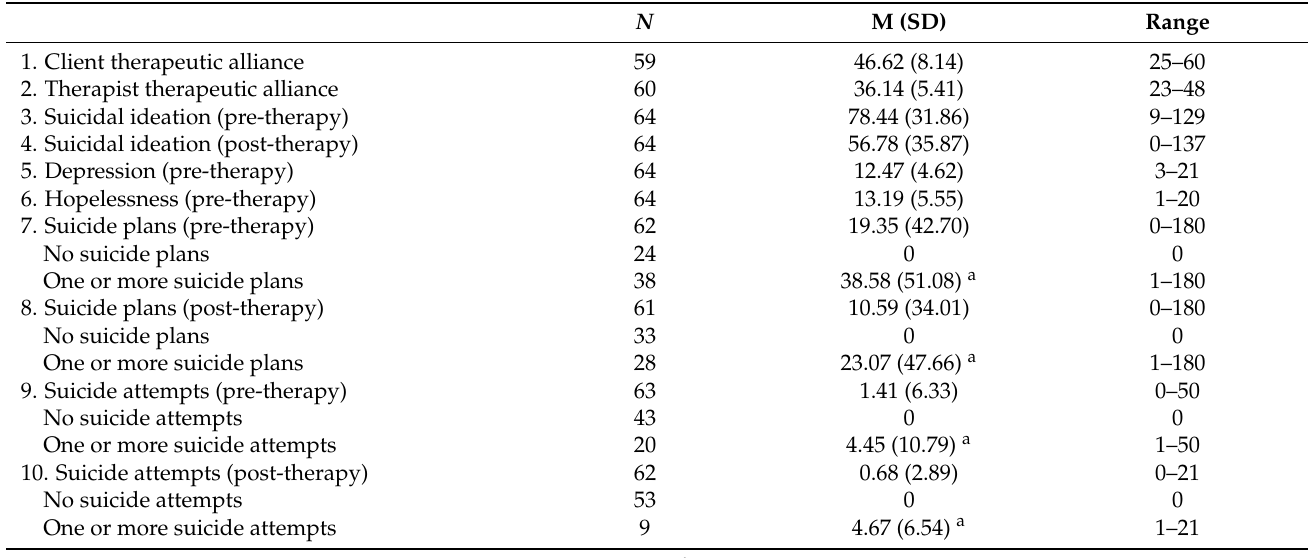
Table 1. Full sample descriptive statistics for client and therapist therapeutic alliance (session 4), suicidal ideation, suicide plans, suicide attempts (pre- and post-therapy), and depression and hopelessness